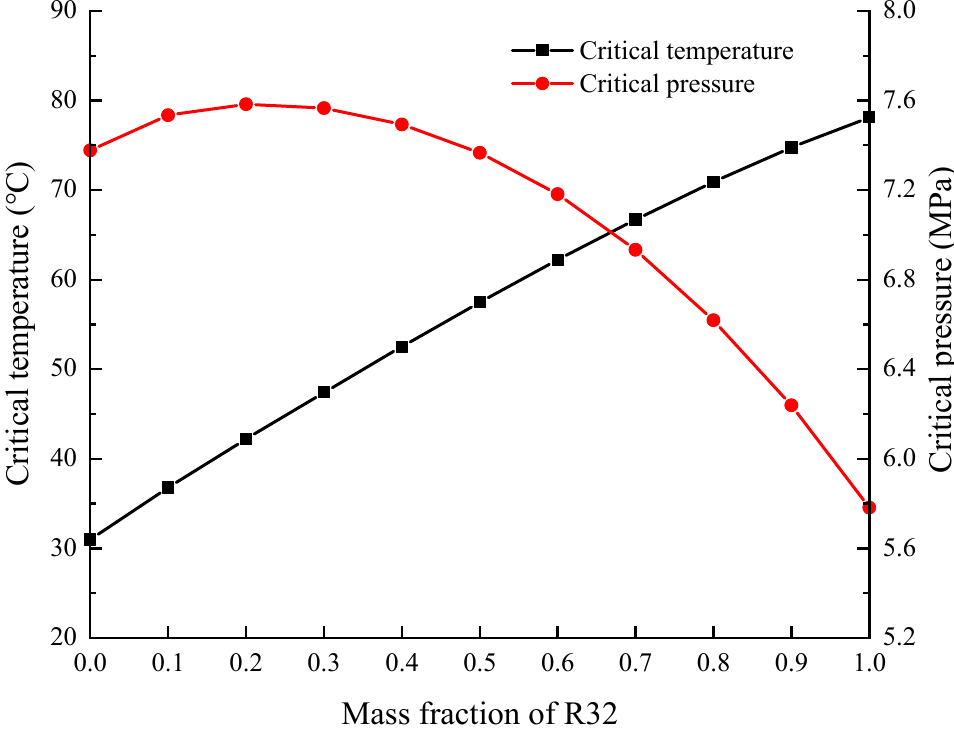
Figure 3. Critical temperature and critical pressure of the CO 2 -based mixture. In order to compare the effect of the mass fraction of R32 on the system’s maximum COP, the calculated COP results at the optimal discharge pressure, at an ambient tempera- ture of 15 ◦ C, are depicted in Figure 4. Interestingly, the COP variation is not increased or decreased in a straight upward or downward trend. Instead, the variation shows a trend similar to that of the letter “M”. When compared to the COP for a system charged with the pure CO 2 refrigerant, the system COP is 0.30–4.25% higher if the mass fraction of R32 is within 0.1–0.3 and 0.41–6.07% higher if it is within 0.7–0.9. With an R32 mass fraction of 0.4–0.6, the system COP is much lower, and the minimum COP is achieved with an R32 mass fraction of 0.5. Therefore, this concentration cannot be adopted due to the lower energy efficiency. Furthermore, although the maximum COP is obtained by a CO 2 /R32 mixture mass fraction of 0.1/0.9, this concentration is also not recommended due to the higher